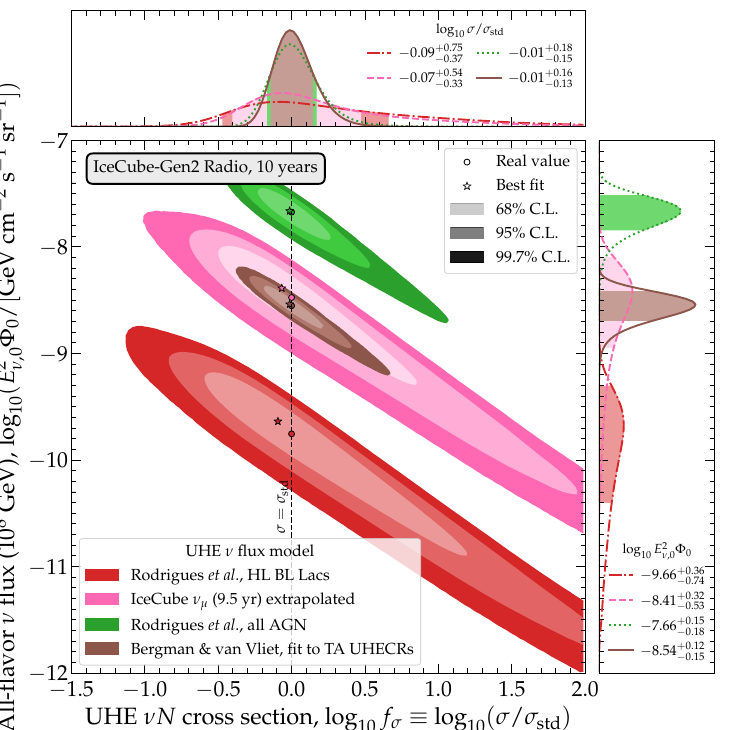
Figure 17 . Mean expected capability of the radio component of IceCube-Gen2 to jointly measure the UHE νN DIS cross section and the diffuse neutrino flux normalization, for representative benchmark flux models 2, 4, 6, and 7 (see figure 5), shown as two-dimensional posteriors. Results account for the background of showers induced by atmospheric muons; see section 7.2. Each posterior is the average over 10 6 random realizations of the shower distribution, binned in reconstructed shower energy and direction; see section 7.4. Results are for the baseline detector design with 144 hybrid (shallow + deep) stations plus 169 shallow-only stations, angular resolution of σ energy resolution of σ = 0 . 1 , and T = 10 years of exposure. See figure 22 for similar results for all (cid:15) flux models, table 2 and figure 23 for marginalized one-dimensional parameter ranges and posteriors, and the main text for